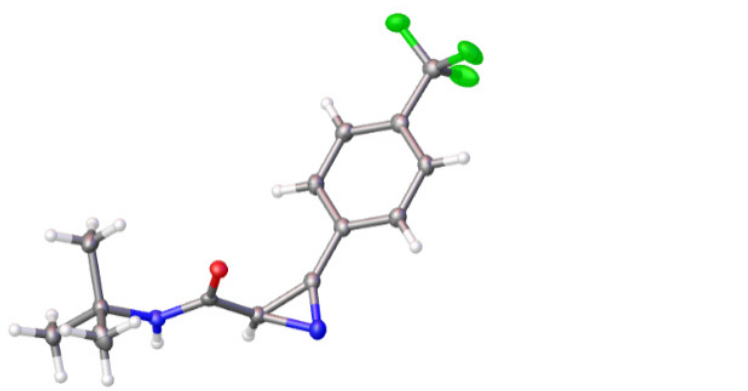
Scheme 6. Synthesis of amides 7h–q .